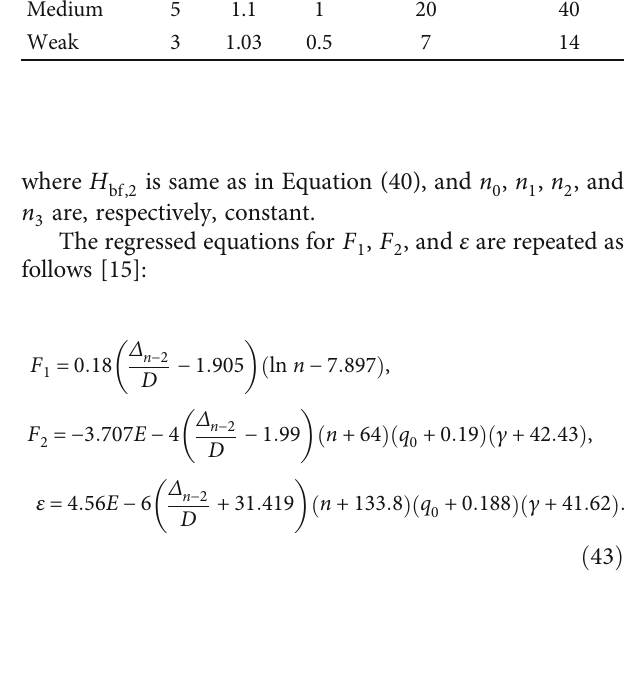
, γ , h , and h for di ff erent fl uid- cr,bf,1 cr,bf,2 0